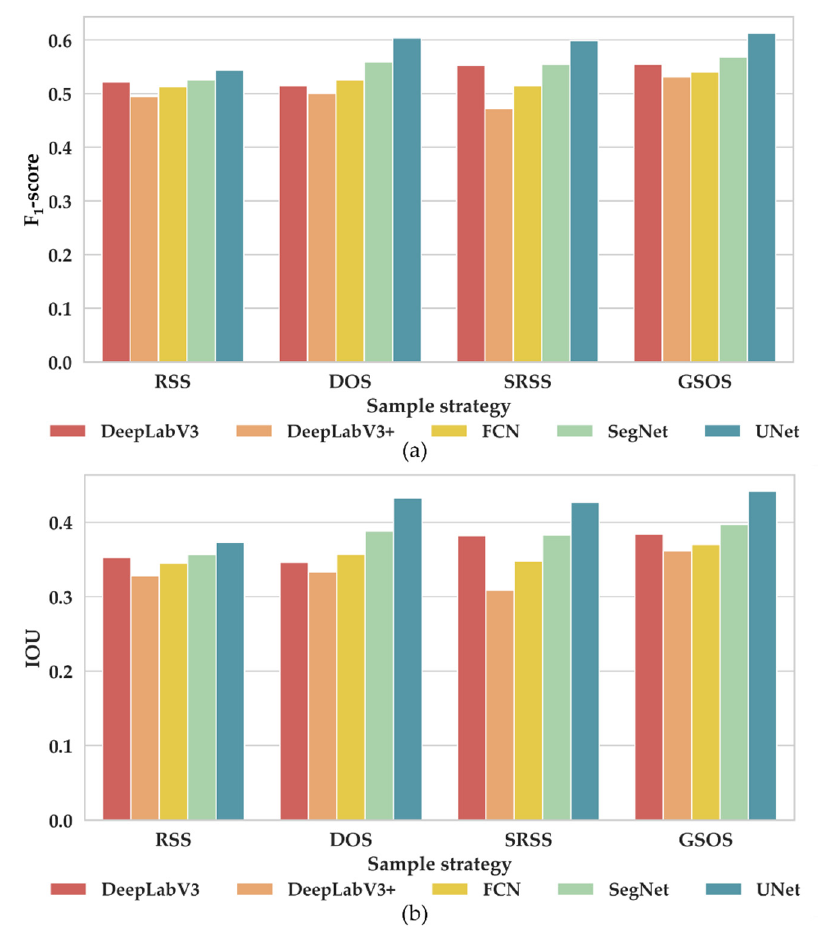
Figure 9. Effect curve of four sampling strategies on the rooftop extraction accuracy under different network models. ( a ) effect curve under the F 1 -score metrics; ( b ) effect curve under the IoU metrics.